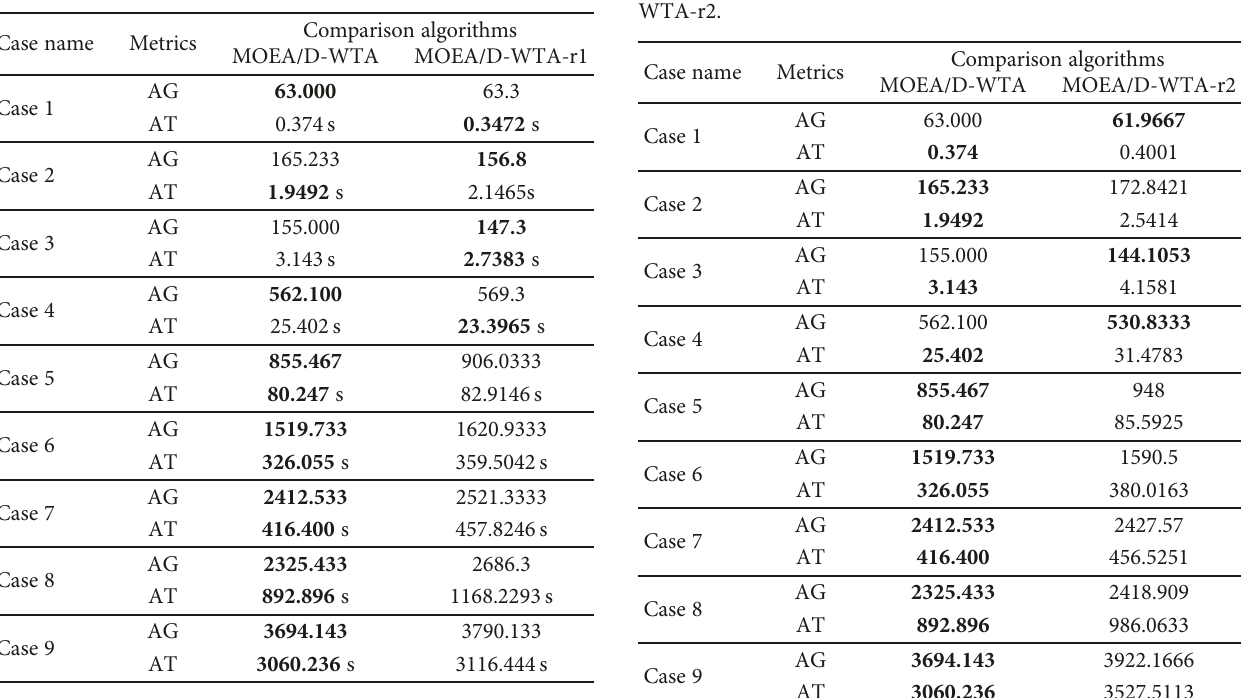
Table 6: Results of AG and AT for MOEA/D-WTA and MOEA/ D-WTA-r1.